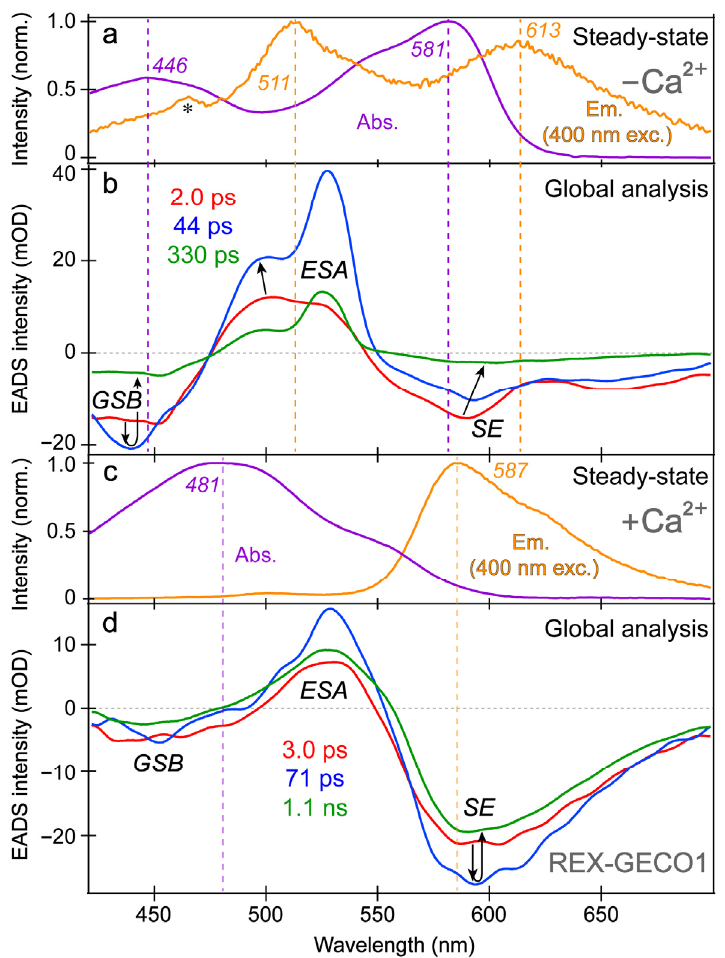
Figure 3. Steady-state electronic spectroscopy and global analysis of the fs-TA spectra of REX-GECO1 in pH 7 aqueous buffer. The steady-state absorption (purple) and emission (orange, with 400 nm excitation) spectra are displayed for the ( a ) Ca 2+ -free and ( c ) Ca 2+ -bound REX-GECO1, respectively. Major peaks are labeled. The asterisk in ( a ) marks a small water scattering peak on top of the weak fluorescence profile. The sequential evolution-associated difference spectra (EADS, red → blue → green) of the ( b ) Ca 2+ -free and ( d ) Ca 2+ -bound REX-GECO1 are shown with the retrieved excited state lifetimes (color-coded) after 400 nm excitation. The vertical dashed lines highlight the steady-state peak wavelengths with respect to transient spectral features, while the black arrows in ( b , d ) highlight the spectral evolution in GSB, ESA, and SE regions.